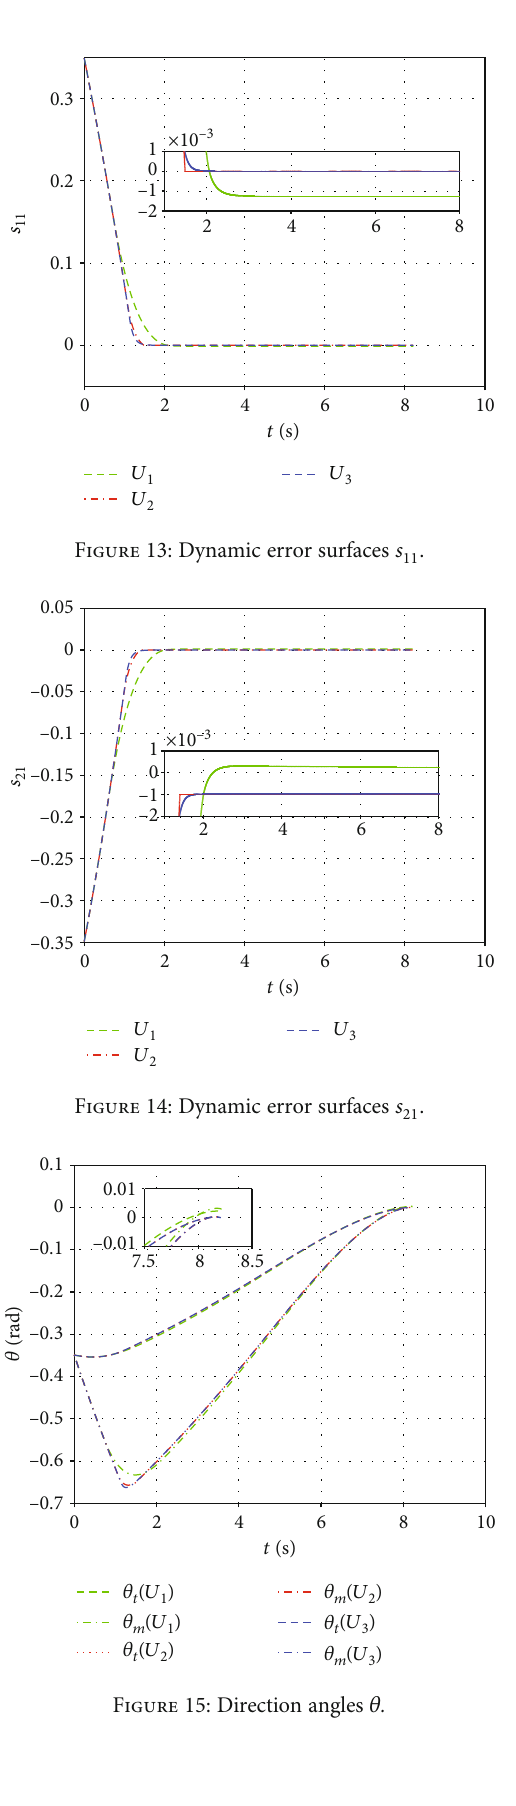
Figure 15: Direction angles θ .